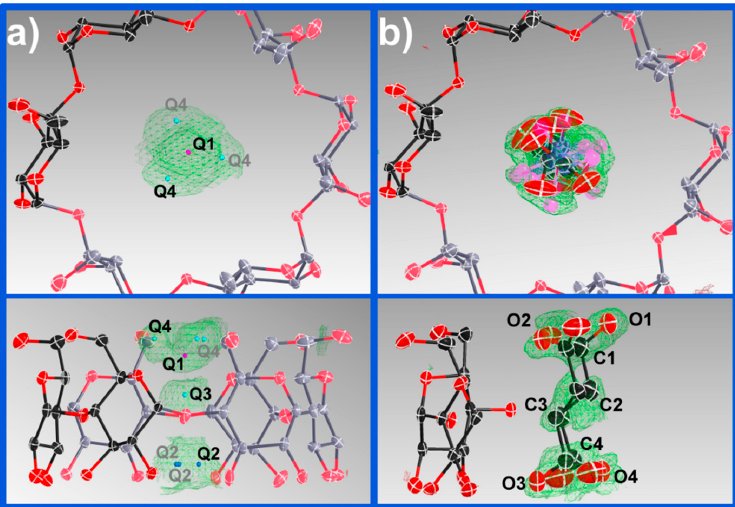
Figure 7. F obs - F calc maps in green showing the electron density before ( a ) and after ( b ) modeling SA inside α -CD B molecule. The peaks Q1 and 3 × (Q4) are forming a tetrahedron. H-atoms and the rest of the structure have been omitted for clarity. Displacement ellipsoids are drawn at the 50% probability level.